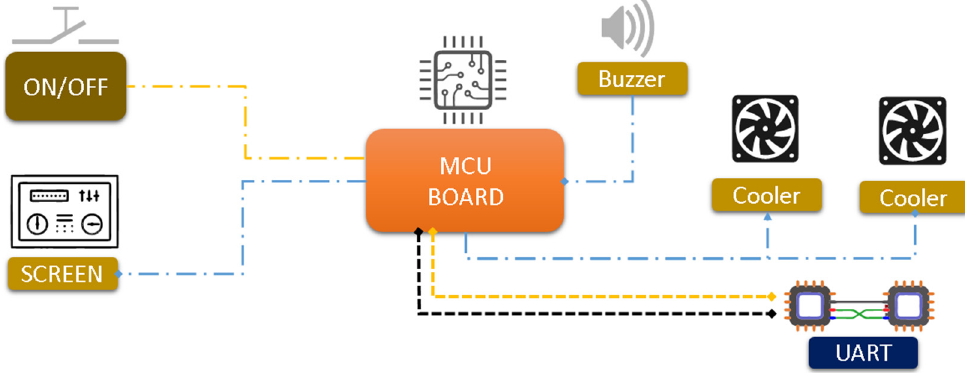
Figure 5. Block diagram of the processing circuit.